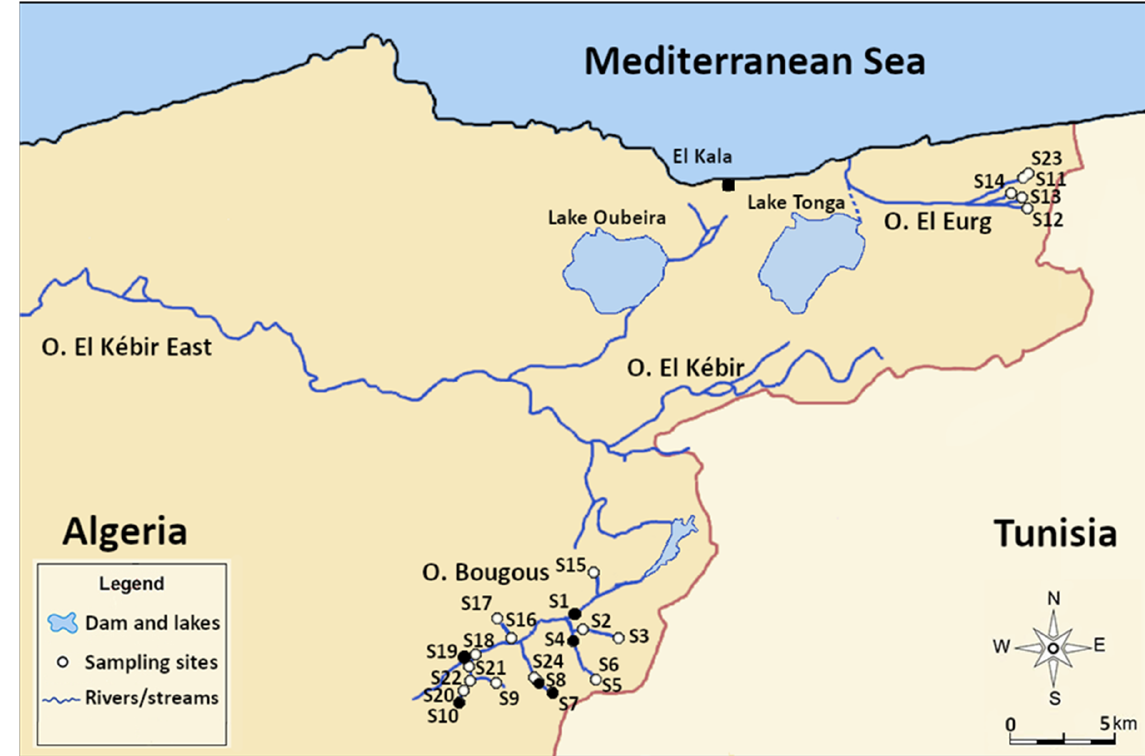
Figure 1. Study area with sampling sites. Dark circles indicate localities where Rhithrogena sartorii has been recorded.